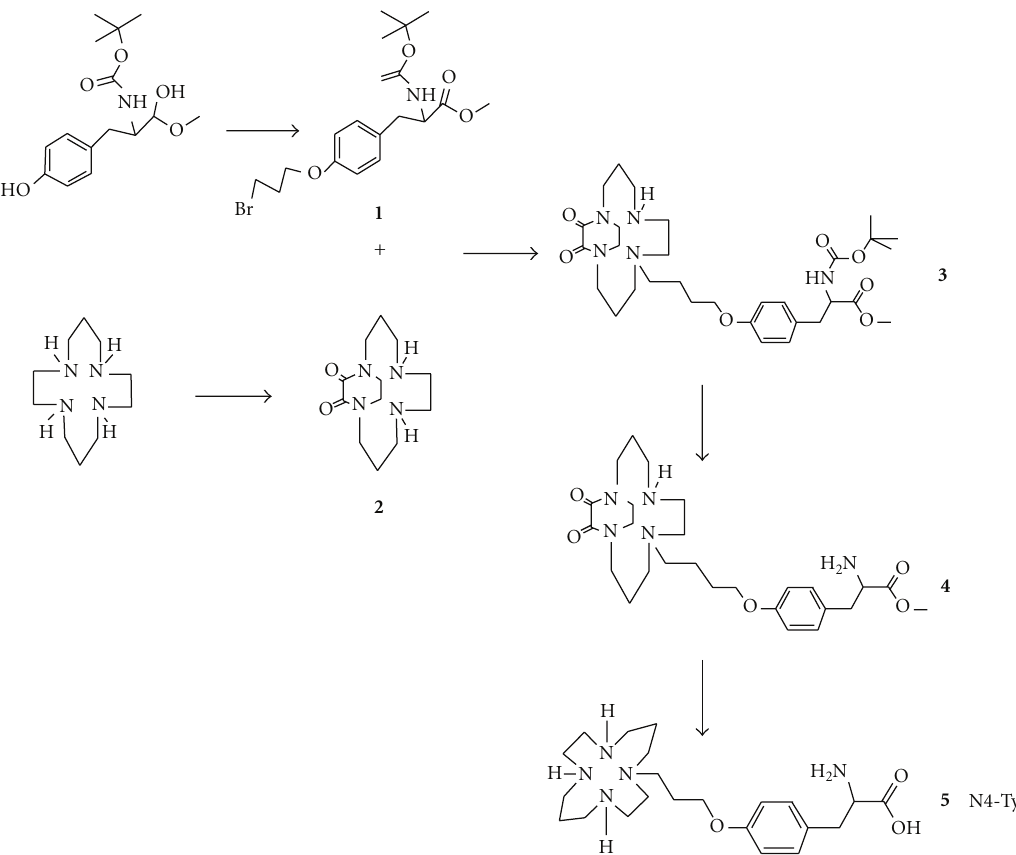
Figure 1: Synthetic scheme of precursor N4-Tyrosine.